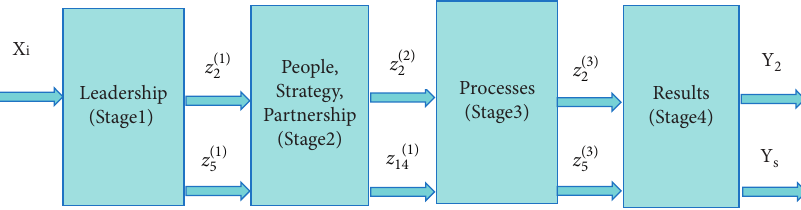
Figure 4: The structure of the proposed EFQM-Fuzzy Network DEA